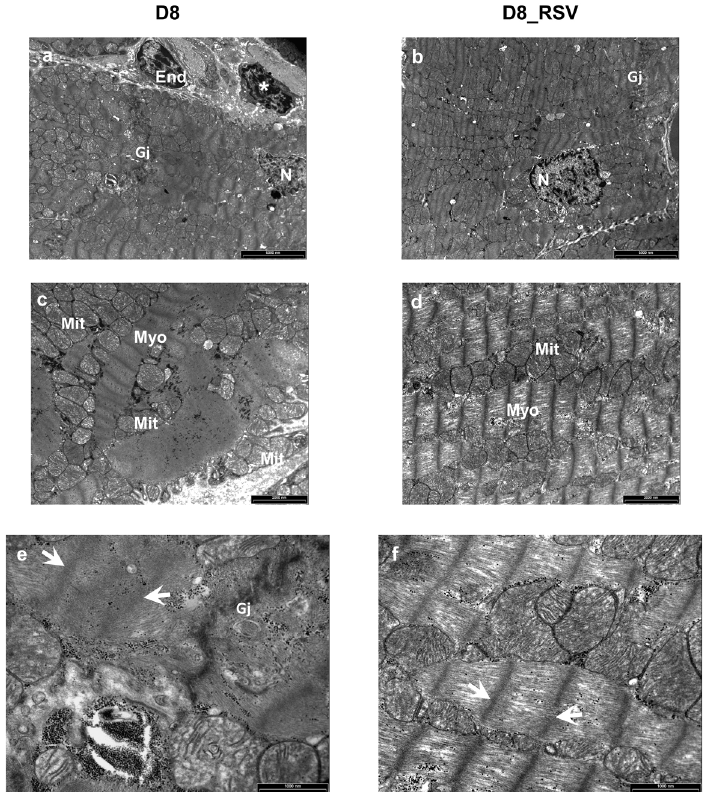
Figure 9. Positive effects of RSV treatment on ultrastructural damage of diabetic LV myocardium. Ultra ‐ thin longitudinal sections of the LV myocardium from untreated (D8) and RSV ‐ treated (D8_RSV) diabetic rats. ( a , b ) Low magnification images illustrating cardiomyocytes connected by gap junctions (Gj). An inflammatory cell (*) showing electron ‐ dense granules near a capillary endothelial cell (End) is also documented in the diabetic rat myocardium ( a ). N: cardiomyocyte nuclei. ( c , d ) Disorganization and severe alteration of contractile myofibrils (Myo) are illustrated in the diabetic myocardium ( c ) whereas a more preserved sarcomere striation is present in RSV ‐ treated heart ( d ). Mitochondria (Mit) are running parallel to myofibrils in RSV ‐ treated rat myocardium ( d ) which are swollen and clustering between disarrayed contractile filaments in diabetic rats ( c ). At higher magnification, a marked ultrastructural effacement of sarcomeres (white arrows) at the junctional interface (Gj) of diabetic cardiomyocytes ( e ) compared to RSV ‐ treated myocardium ( f ) is apparent. Scale bars: ( a , b ): 5 μ m; ( c , d ): 2 μ m; ( e , f ): 1 μ m.